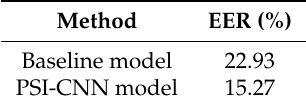
Figure 5. A performance comparison of face recognition models for different image resolutions based on the Euclidean distance. Table 4. A performance comparison between the baseline and PSI-CNN models on own CCTV